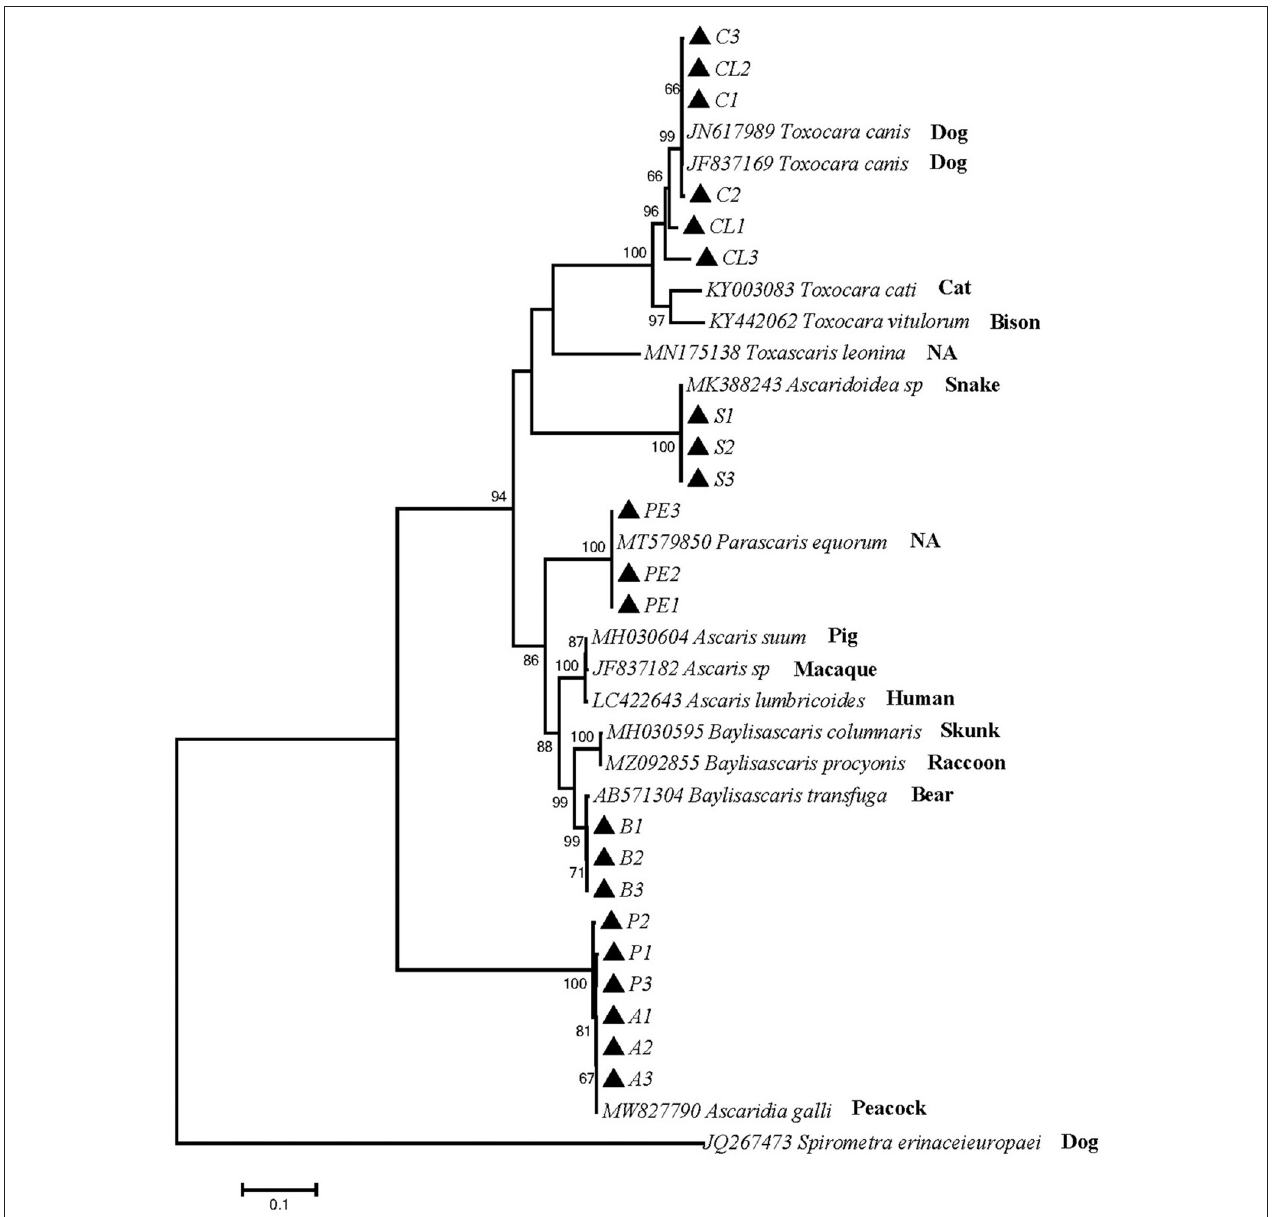
FIGURE 4 | Neighbor-Joining estimates of the phylogenetic relationships of ascarids based on ITS gene computed in MEGA version 7.0 under the Kimura 2-parameter model; The confidence levels in each node were assessed with the bootstrap method (1,000 pseudoreplicates) and bootstrap values > 50;The genotypes identified in this study are indicated by filled